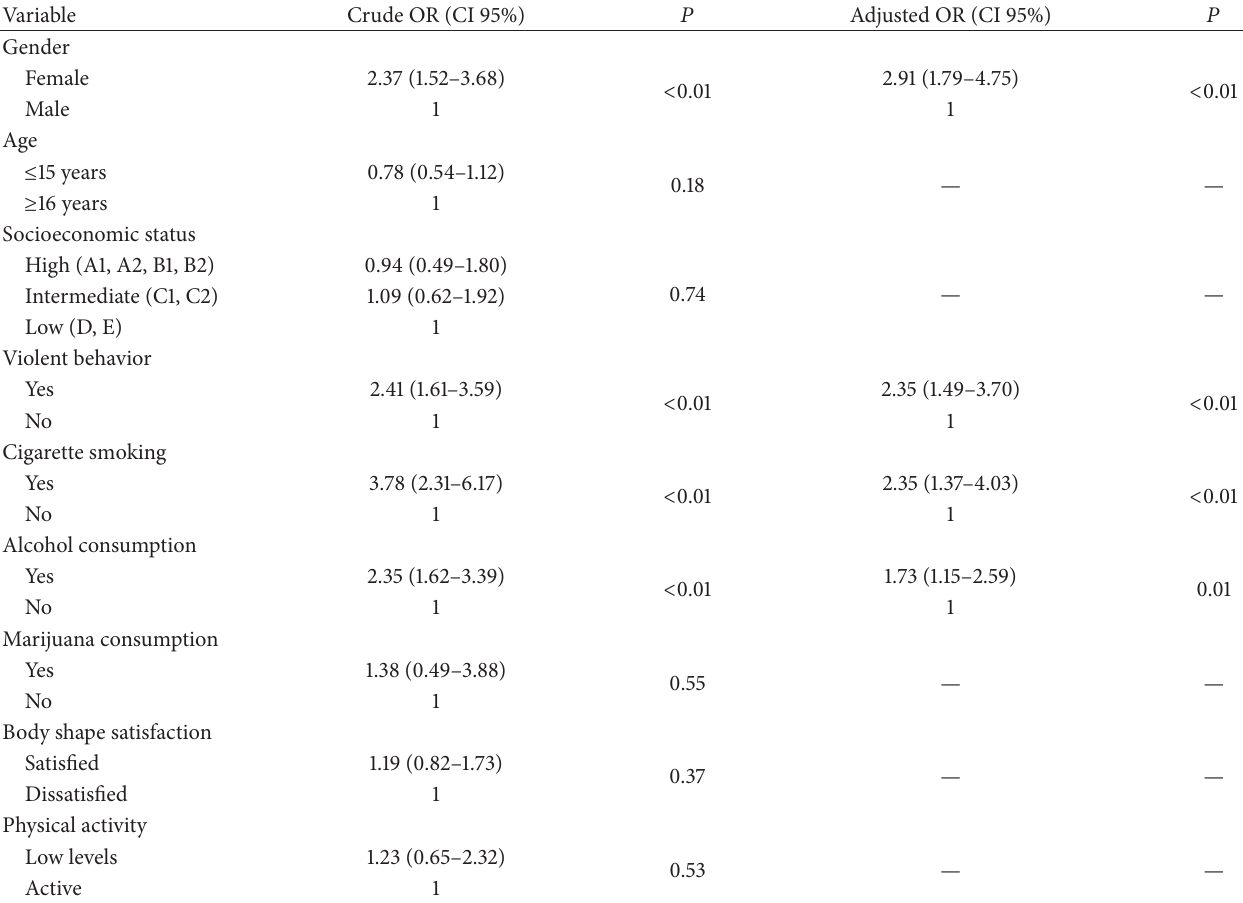
Table 5: Crude and adjusted odds ratio for behavior “suicide attempt” among adolescents in Northeastern Brazil, 𝑛 = 2207.